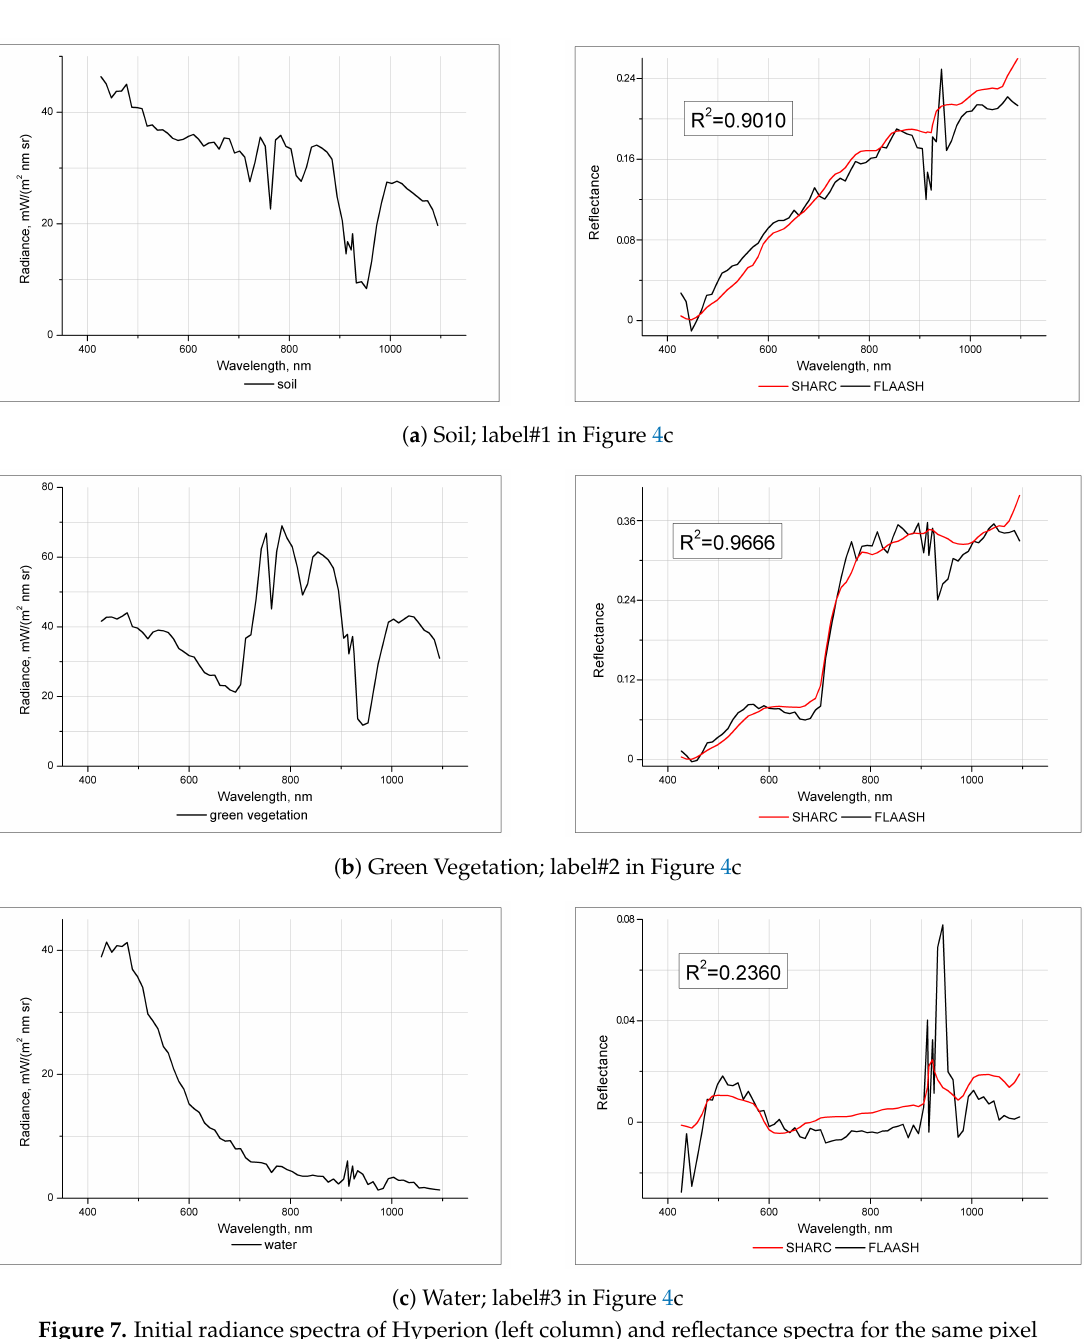
Figure 7. Initial radiance spectra of Hyperion (left column) and reflectance spectra for the same pixel retrieved by the SHARC atmospheric correction technique (right column) and FLAASH module (ENVI) (right column) for three types of underlying surfaces (soil ( a ), green vegetation ( b ), water ( c )), labeled with pins in Figure